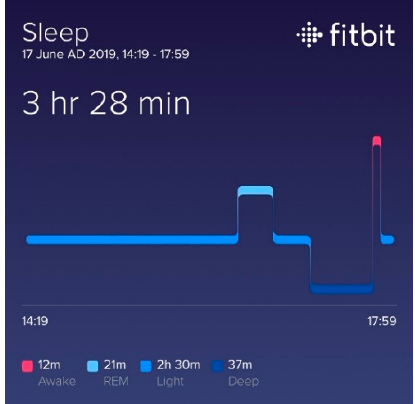
Figure A1. Zurich, Switzerland.